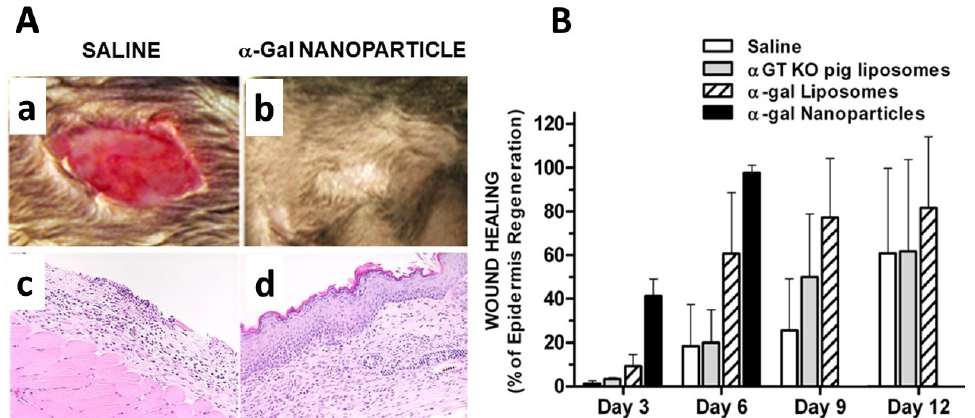
Figure 7. Effect of topical application of α -gal nanoparticles on healing of wounds, determined as proportion of regenerating epidermis covering the wound. ( Aa ) Representative morphology on Day 6 of saline treated oval 6 × 9 mm full thickness excisional wounds. No healing and regeneration are observed. ( Ab ). Wound as in ( Aa ), treated with α -gal nanoparticles. Note the complete healing of the wound which is covered by regenerating epidermis. ( Ac ) Histology of the wound in ( Aa ) (H&E × 100). ( Ad ) Histology of the wound in ( Ab ) (H&E × 100). ( B ) Healing of wounds was evaluated with α -gal nanoparticles (10 mg/mL) (closed columns), α -gal liposomes, which are large α -gal na- noparticles (1–10 μ m, hatched columns), 10 mg GT-KO pig liposomes lacking α -gal epitopes (gray columns), or saline (open columns). Mean + SD from ≥ 5 mice/group. On Day 6, 20 mice were evalu- ated per each group. Modified from ref. [57].